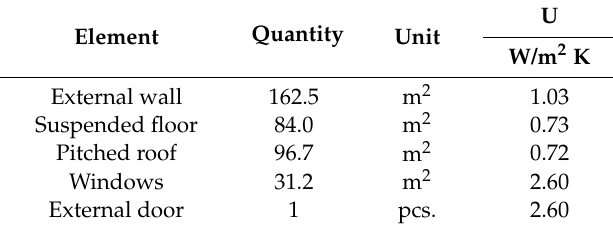
Table 10. The heat transfer coefficients and surfaces of external elements of the one-storey building with an attic. Element Quantity Unit External wall 162.5 m 2 1.03 Suspended floor 84.0 m 2 0.73 Pitched roof 96.7 m 2 0.72 Windows 31.2 m 2 2.60 External door 1 pcs. 2.60